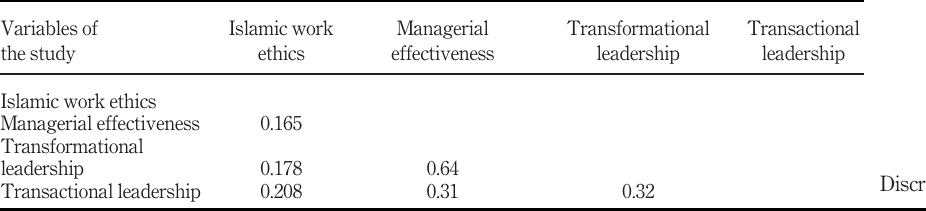
Table 2. Discriminant